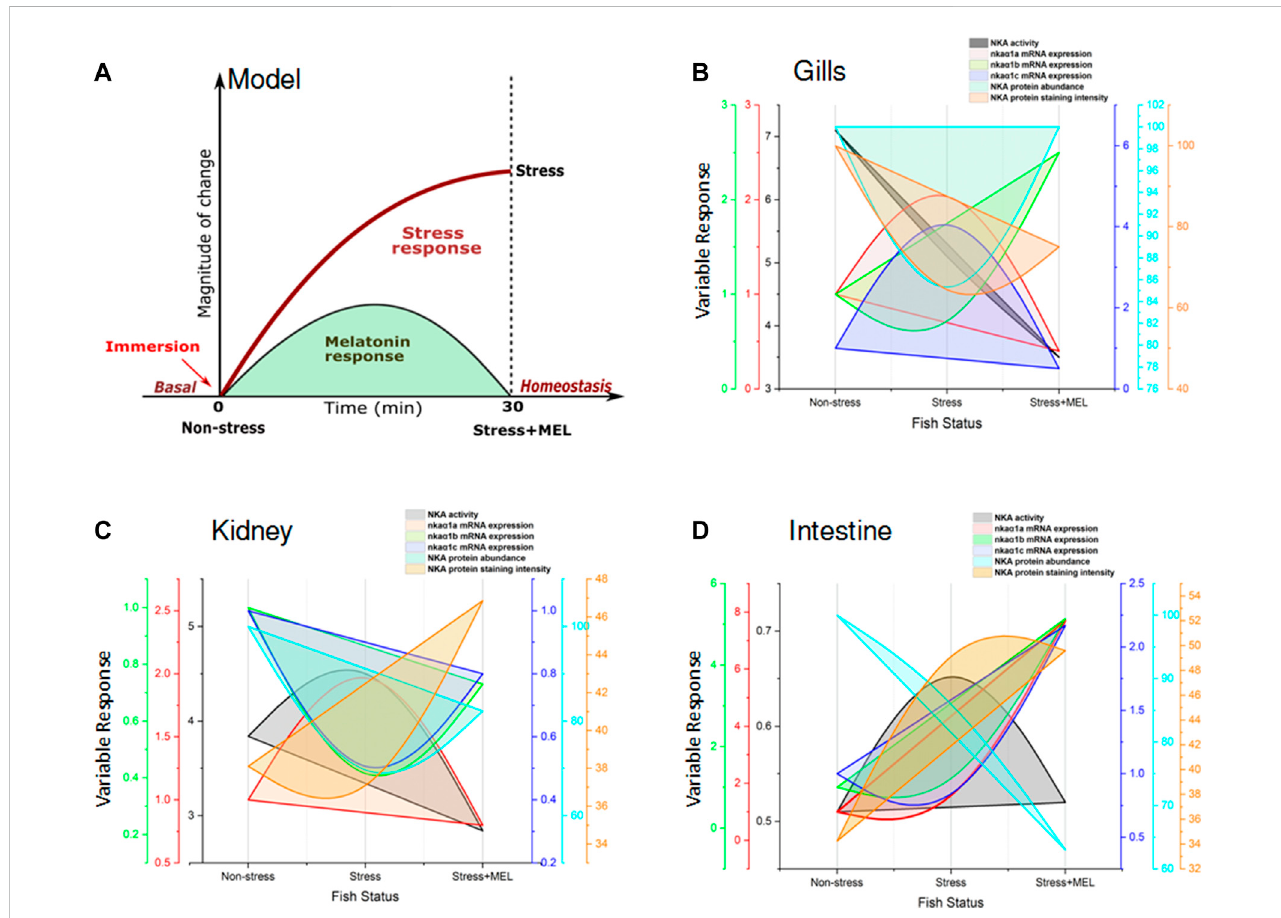
FIGURE 13 Model showing the NKA-driven recovery response by exogenous melatonin (Mel) in gills, kidney and intestine of immersion-stressed (IMR) climbing perch. The proposed model (A) represents a typical pattern of stress response in fi sh held for 30 min immersion stress against non-stressed condition. Immersion-stressed fi sh groups that received exogenous melatonin showed melatonin response as recovery response. In the subsequent fi gures (B,D) , the responses of tested NKA-regulatory parameters were plotted against three fi sh groups such as non-stressed, immersion-stressed and immersion stress plusmelatonin.Theresponseofgills (B) ,kidney (C) andintestine (D) ofthese fi shfortimeframe(0 – 30 min)wereplottedonX-axis.Themagnitudeofchanges in the NKA functions, quanti fi ed as NKA activity, isoform nka α 1a , nka α 1b and nka α 1c mRNA expression, NKA α protein abundance and